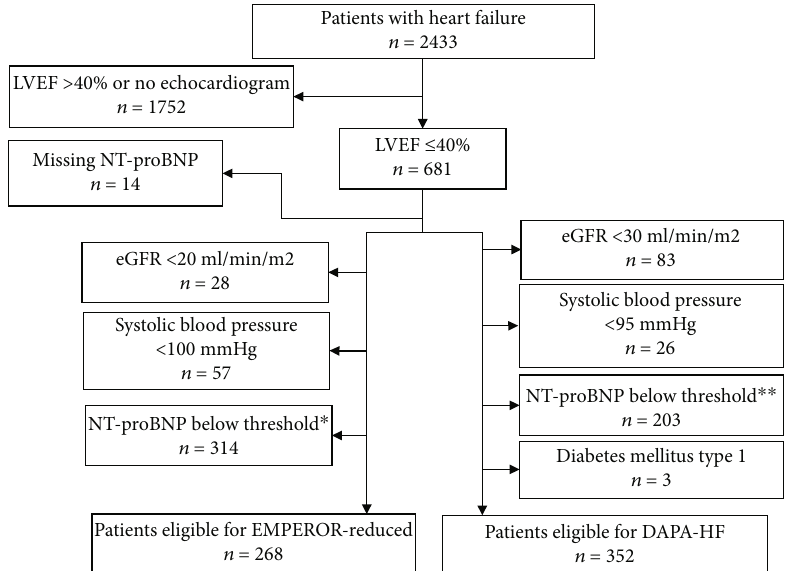
Figure 1: Selection of patients eligible for DAPA-HF and EMPEROR-reduced in the Umeå heart failure population when using applicable criteria from the DAPA-HF and EMPEROR-reduced trials. LVEF: left ventricle ejection fraction; eGFR: estimated glomerular fi ltration rate; NT-proBNP: N-terminal pro-B-type natriuretic peptide. ∗ < 600 pg/ml in patients with recent hospitalization or LVEF < = 30 % , < 1000 if LVEF 31-35%, and < 2500 if LVEF 36-40%; doubled minimum values in patients with atrial fi brillation on latest ECG. ∗∗ < 600pg/ml , or < 400 pg/ml if hospitalization event for heart failure within last 12 months, or < 900pg/ml if last ECG showed atrial fi brillation or fl utter.